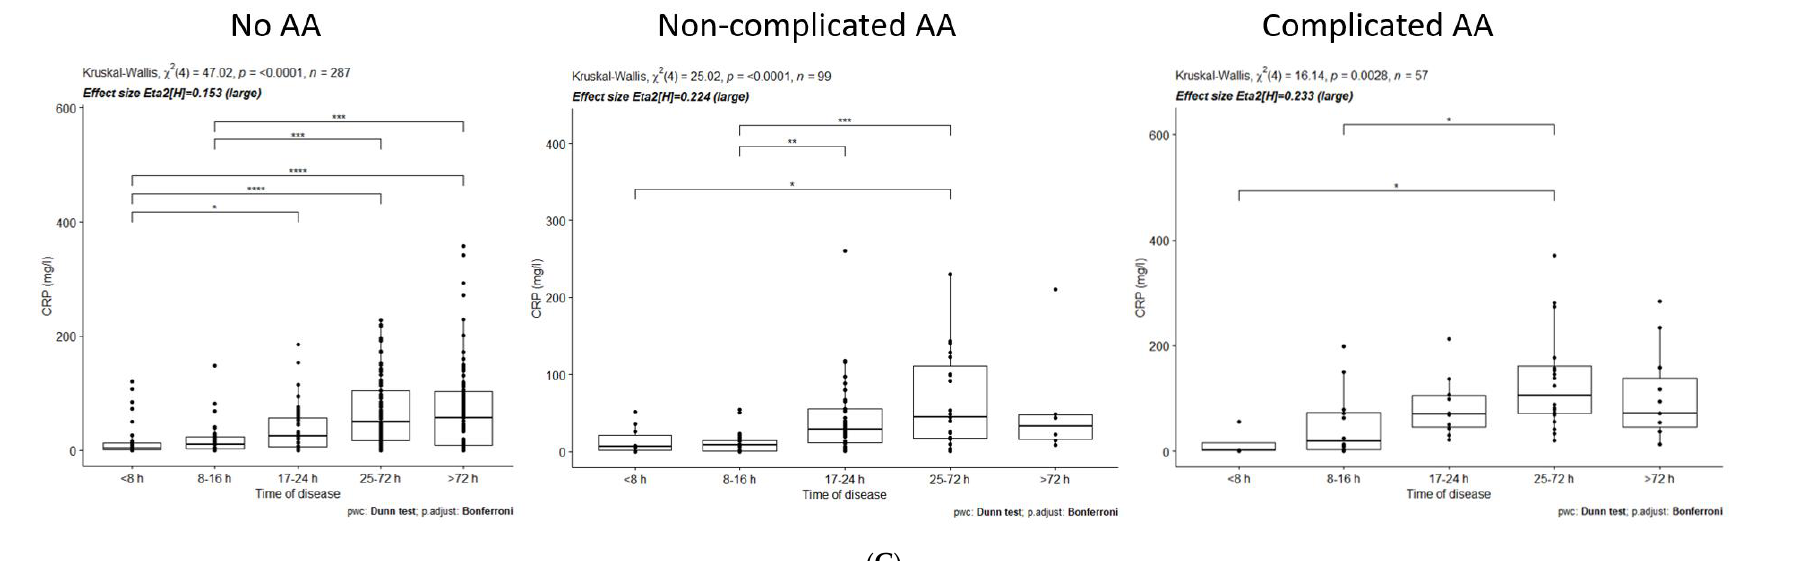
Figure 1. ( A ). No-AA—no acute appendicitis group, NAA—non-complicated acute appendicitis group, CAA—complicated acute appendicitis group, WBC—white blood cell, NEU—neutrophils. ( B ). No-AA—no acute appendicitis group, NAA—non-complicated acute appendicitis group, CAA—complicated acute appendicitis group, LYMP—lymphocytes, NEU/LYMP—neutrophil to lymphocyte ratio. ( C ). No-AA—no acute appendicitis group, NAA—non-complicated acute appendicitis group, CAA—complicated acute appendicitis group, CRP—C-reactive protein. *,**, *** and **** – indicates statistically significant differences between groups.